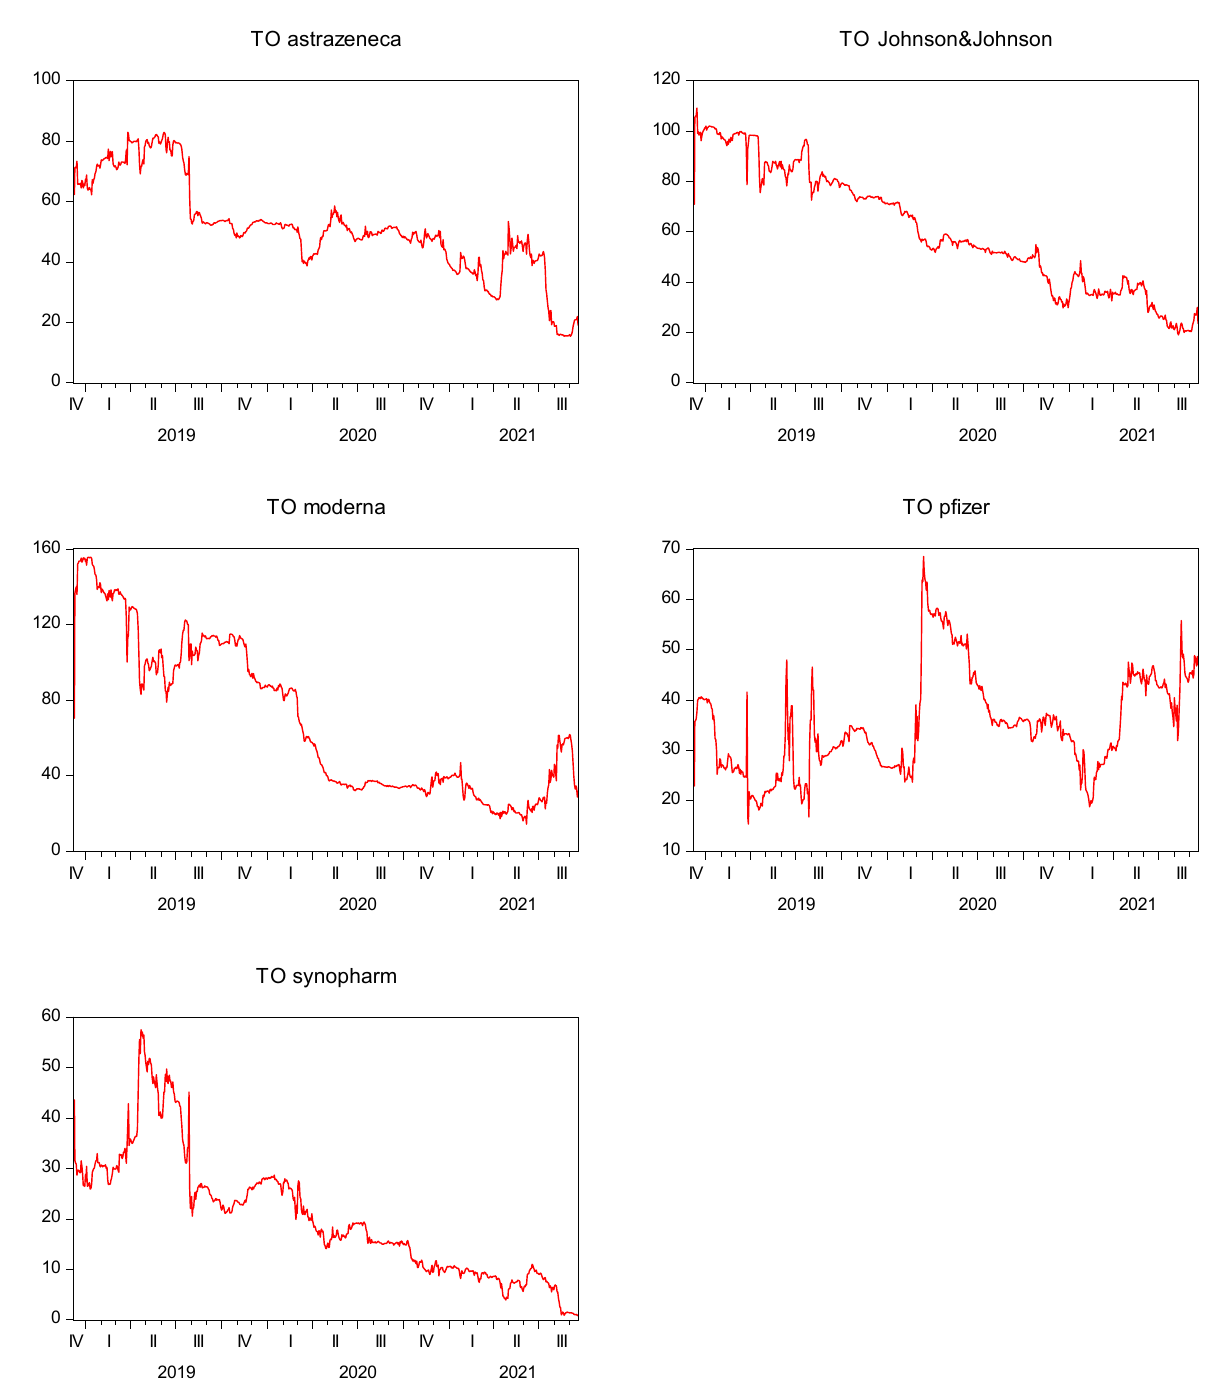
Figure A2. Volatility transmission to AstraZeneca, Johnson & Johnson, Moderna, Pfizer and Si- nopharm.